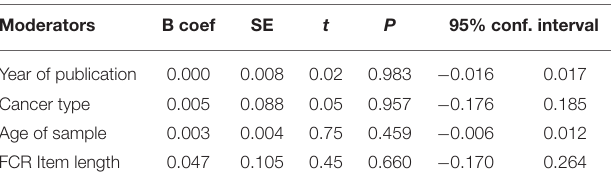
TABLE 3 | Meta-regression of effect sizes by four covariates: year of publication, cancer type, age of sample, and FCR measurement on gender by fears of cancer recurrence